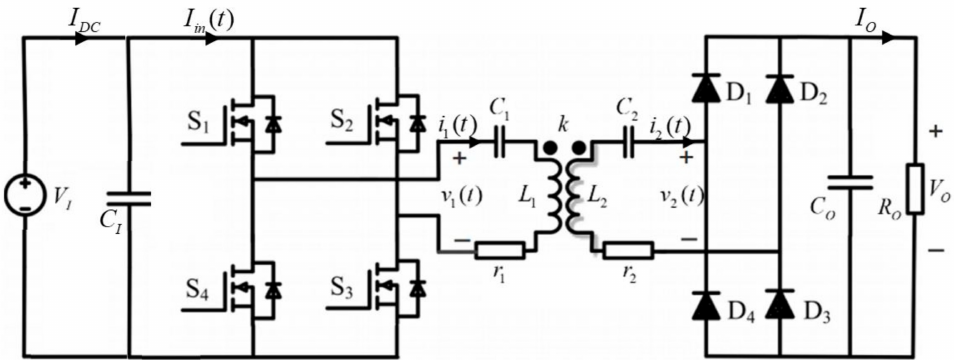
Figure 2. SS-compensated IWPT